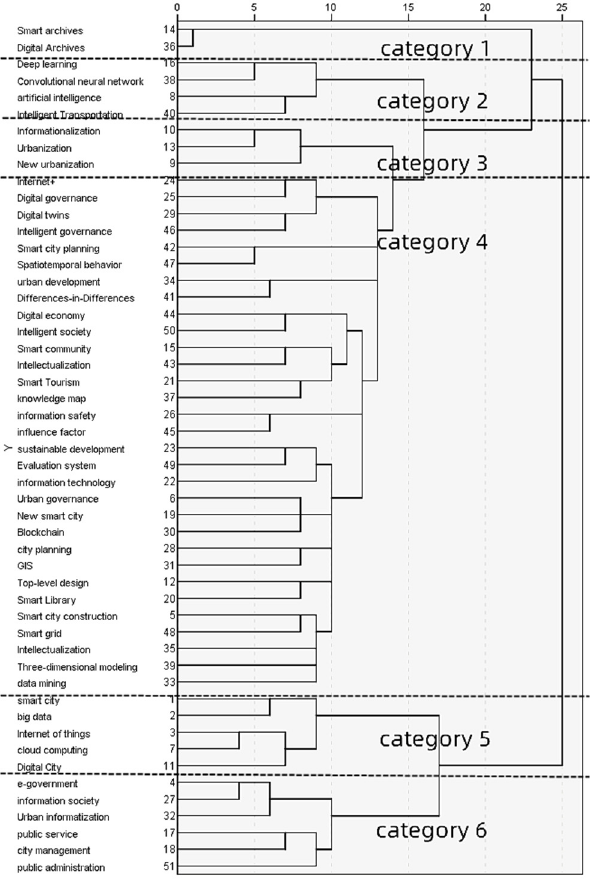
Figure 5. Hierarchical cluster analysis of high-frequency